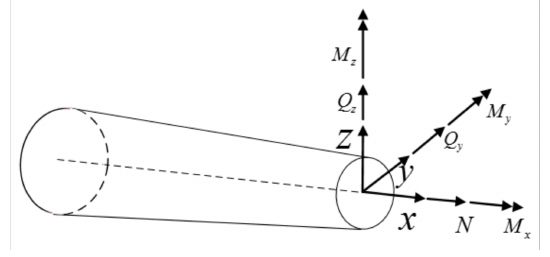
Figure 2. The force form of the